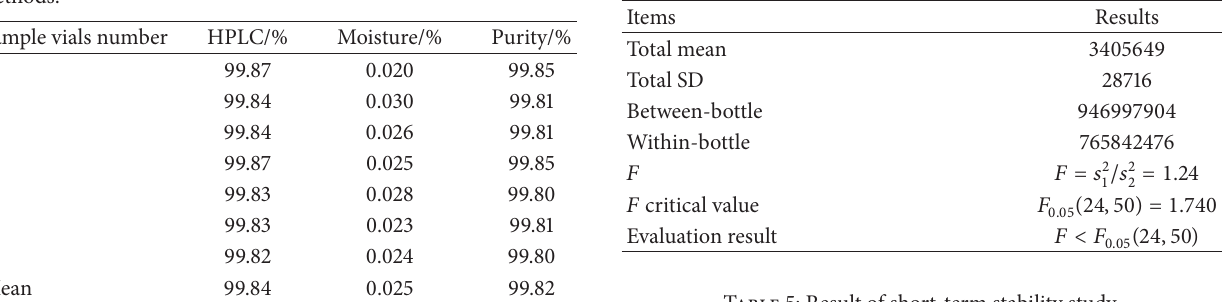
Table 4: Results of homogeneity study.